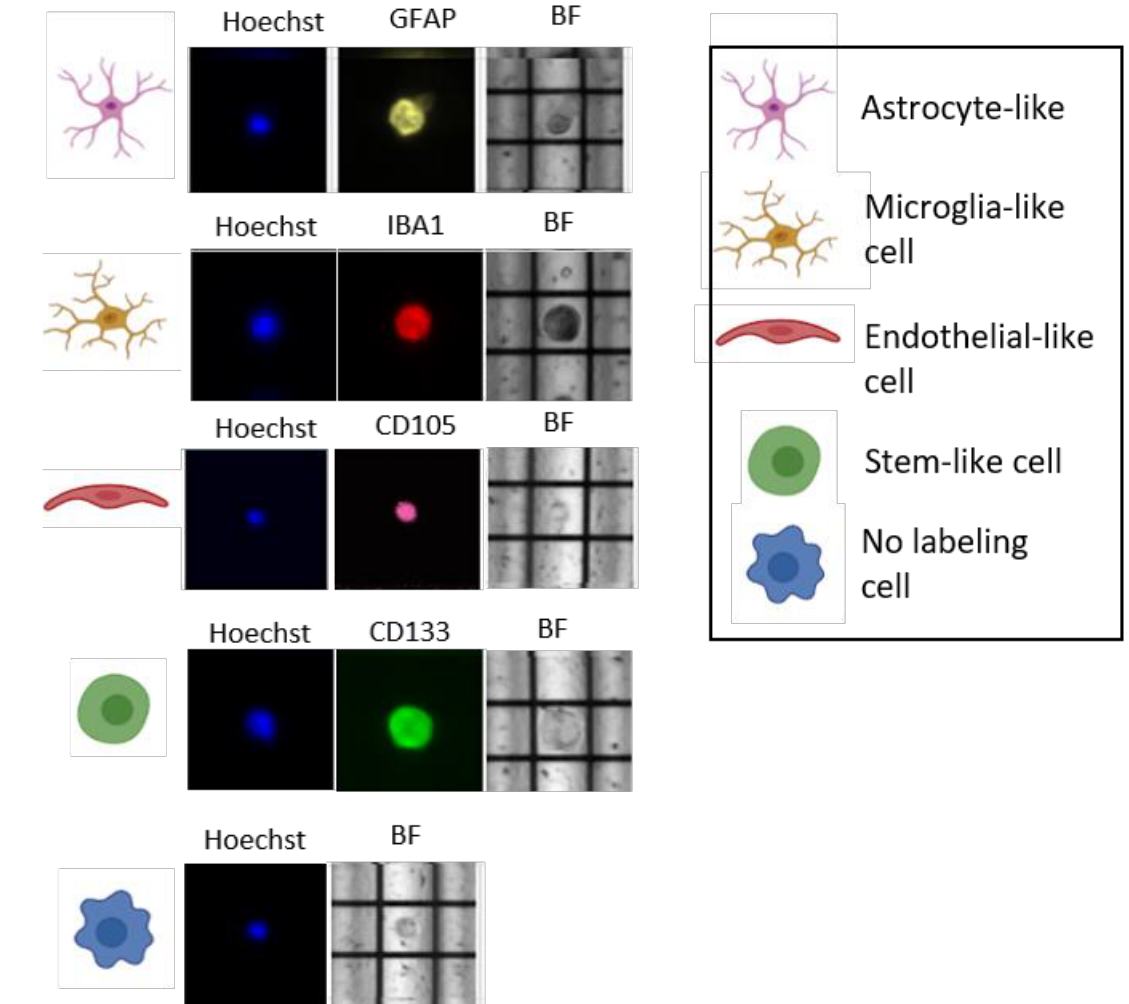
Figure 2. Example of DEPArray images of single cells belonging to the main GB populations, stained in yellow with GFAP (astrocytes-like), in red with IBA1 (microglia-like), in purple with CD105 (endothelial-like cells), in green with CD133 (stem-like cells) and in blue with Hoechst. BF: Brightfield.